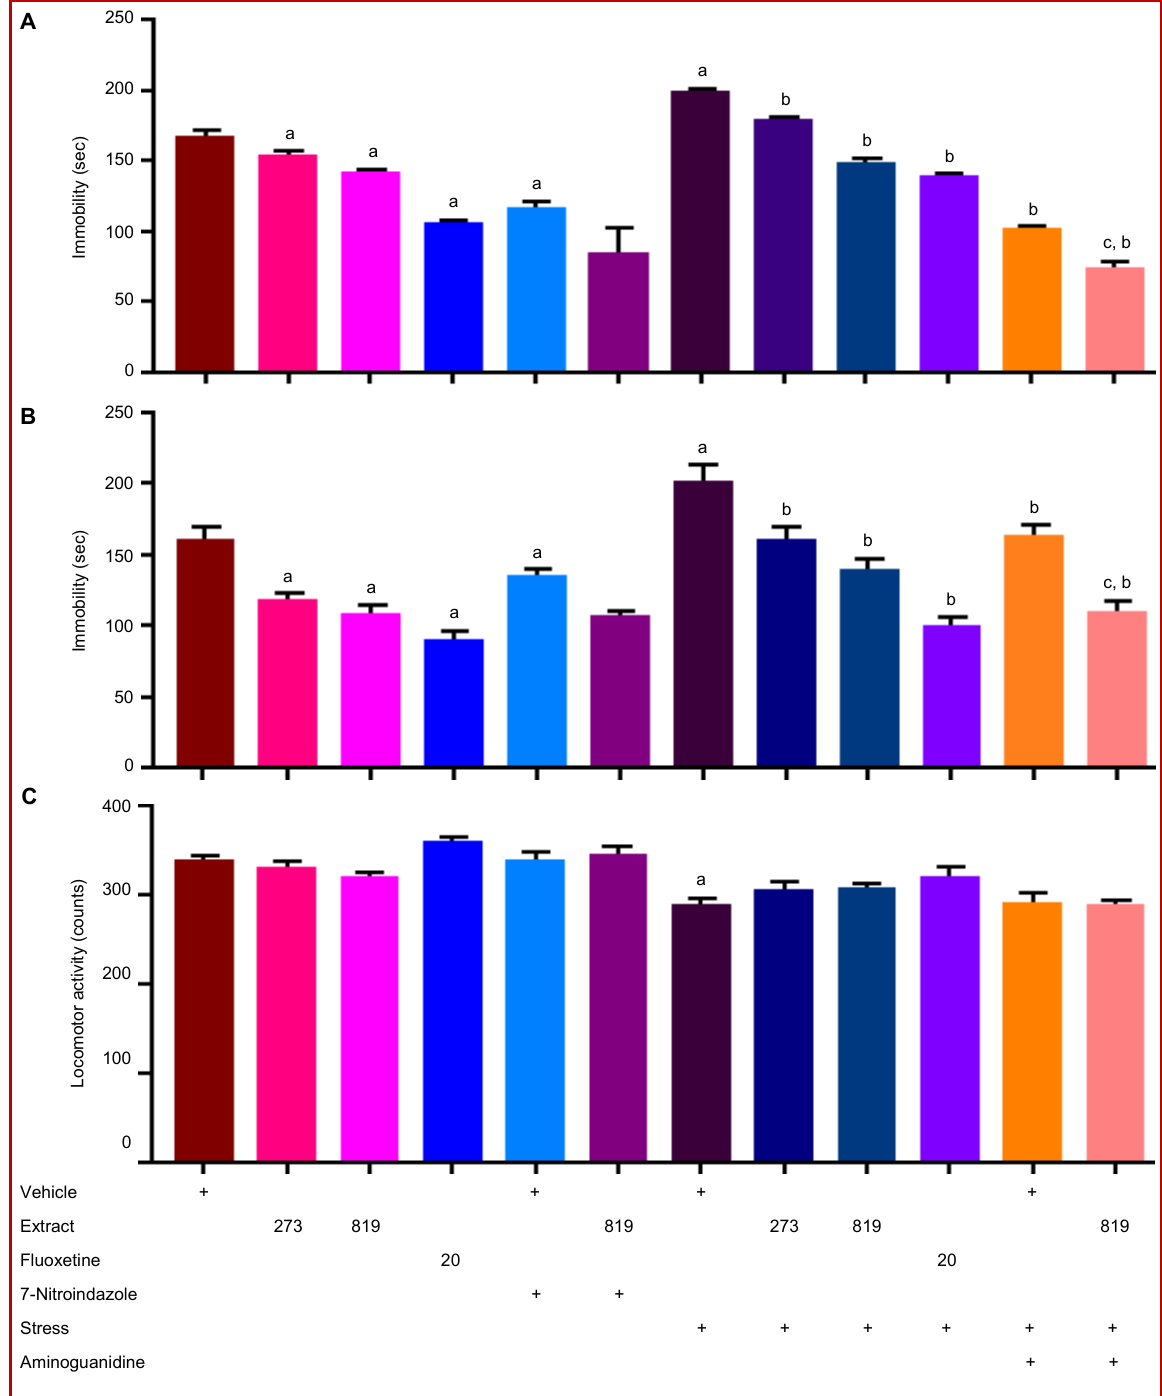
Figure 1: Effect of A. blazei and its combinations with 7-nitroindazole and aminoguanidine on immobility periods [using tail suspension test (A) and forced swim test (B)] and locomotor activity (C) of unstressed and stressed mice n=6 in each group; Values are expressed as the mean ± SEM; Data were analyzed by one- way ANOVA followed by Tukey’s test, except data for unstressed and stressed mice, which were analyzed by Student’s unpaired t -test. a p<0.05, significant difference from vehicle-treated unstressed mice); b p<0.05, significant difference from immobilization-induced stressed mice; c p<0.05, significant difference from A. blazei (819 mg/kg)-treated stressed mice; d p<0.05, significant difference from aminoguanidine-treated stressed